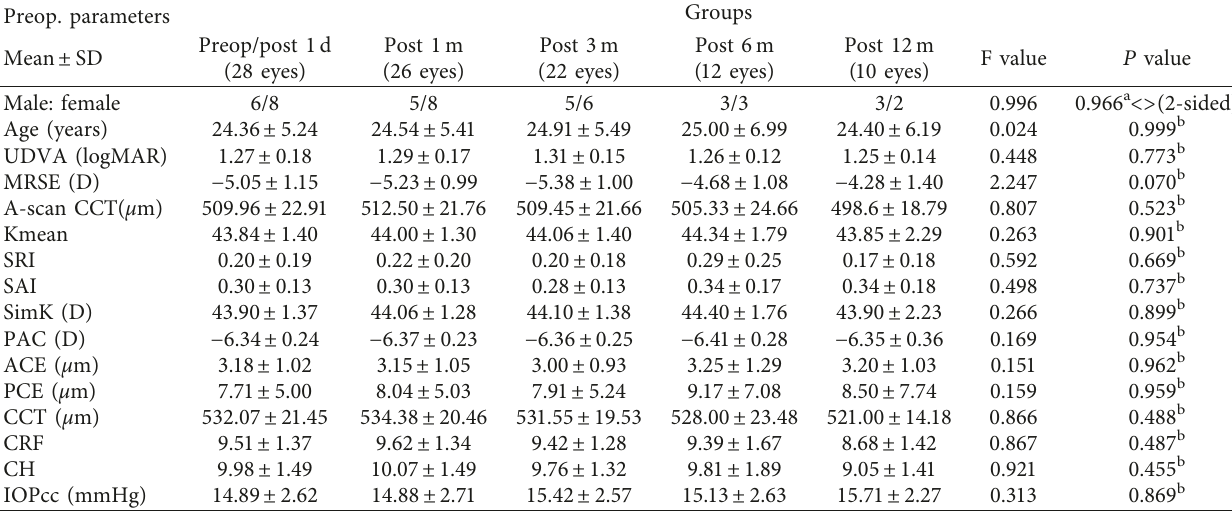
Table 1: Preoperative baseline data of patients who underwent SMILE Xtra.